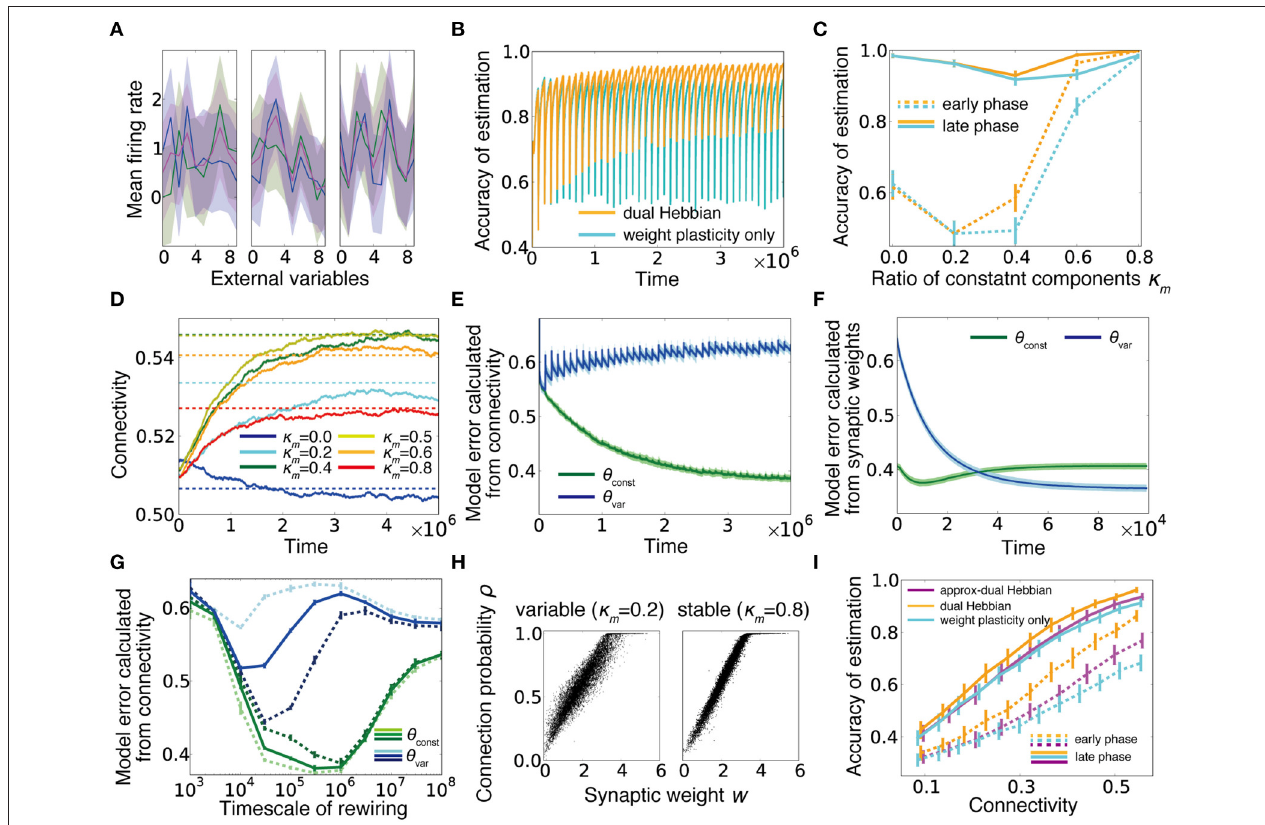
FIGURE 6 | Dual Hebbian learning under a dynamic environment. (A) Examples of input neuron responses. Blue lines represent the constant components θ const , green lines show the variable components θ var , which are updated at every T 2 time steps by sampling a new input structure from a truncated Gaussian distribution (see Section Gaussian Model), and magenta lines are the total external models θ calculated from the normalized sum. (B) Learning curves for the model with or without wiring plasticity, when the variable components change every 10 5 time steps. (C) Accuracy of estimation for various ratios of constant components. Early phase performance was calculated from the activity within 10,000 steps after the variable component shift, and the late phase performance was calculated from the activity within 10,000 steps before the shift. As in (B) , orange lines represent the dual Hebbian model, and cyan lines are for the model with weight plasticity only. (D) Trajectories of connectivity change. Connectivity tends to increase slightly during learning. Dotted lines are mean connectivity at ( κ m , γ ) (0.4, 0.64), (0.5, 0.64), (0.6, 0.635), and (0.8, 0.620). In (C) , these parameters were used for the synaptic plasticity only model, whereas γ was fixed at γ dual Hebbian model. (E,F) Model error calculated from connectivity (E) and synaptic weights (F) . Note that the timescale of (F) is the duration in which the variable component is constant, not the entire simulation (i.e., the scale of x-axis is 10 4 not 10 6 ). (G) Model error calculated from connectivity for various rewiring